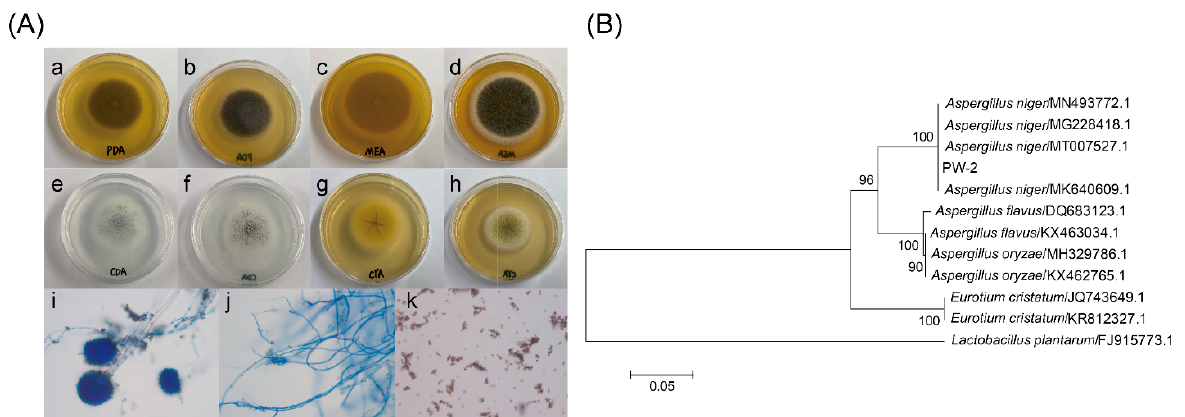
Figure 1. The morphological and molecular identification of Aspergillus niger PW-2 isolated from Pingwu Fuzhuan brick tea. ( A ) Colony feature and microscopic feature of isolated Aspergillus niger PW-2: colony feature after 4 days at 25 °C on PDA (a,b), MEA (c,d) and CYA (g,h), and colony feature after 7 days at 25 °C on CDA (e,f); morphologic characteristics of conidiophores (i), septate hyphae asymmetrically branched (j) and conidia (k) of Aspergillus niger PW-2 under a light microscope. ( B ) Neighbor-joining phylogenetic tree based on the dataset covering the sequences of the ITS gene of isolates and reference strains.